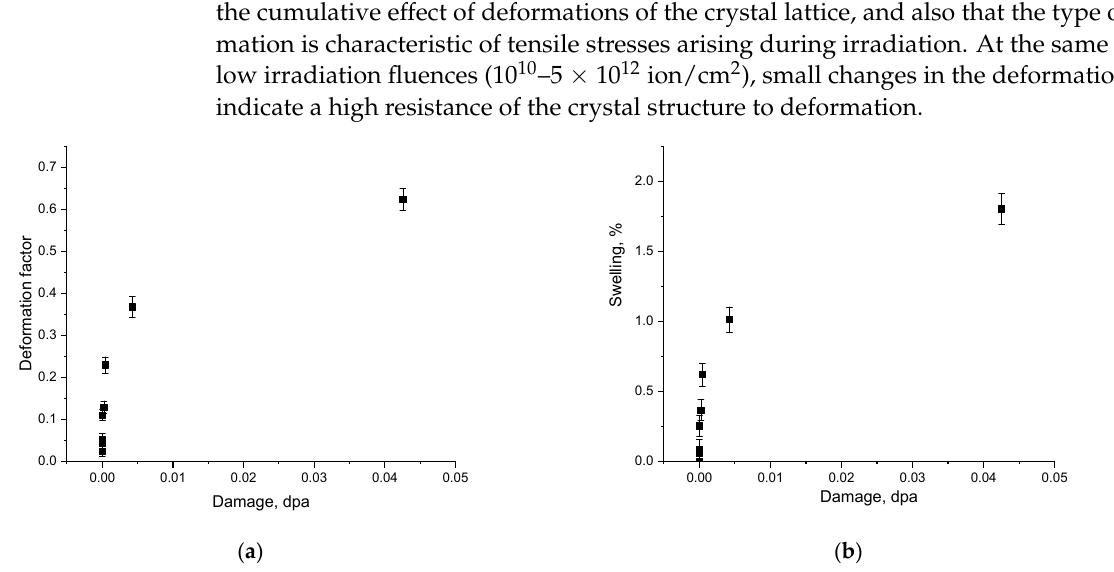
Figure 5. ( a ) Results of the change in the crystal la tt ice deformation factor depending on the value of atomic displacements; ( b ) results of the change in the value of the crystal la tt ice volume swelling on the value of atomic displacements.